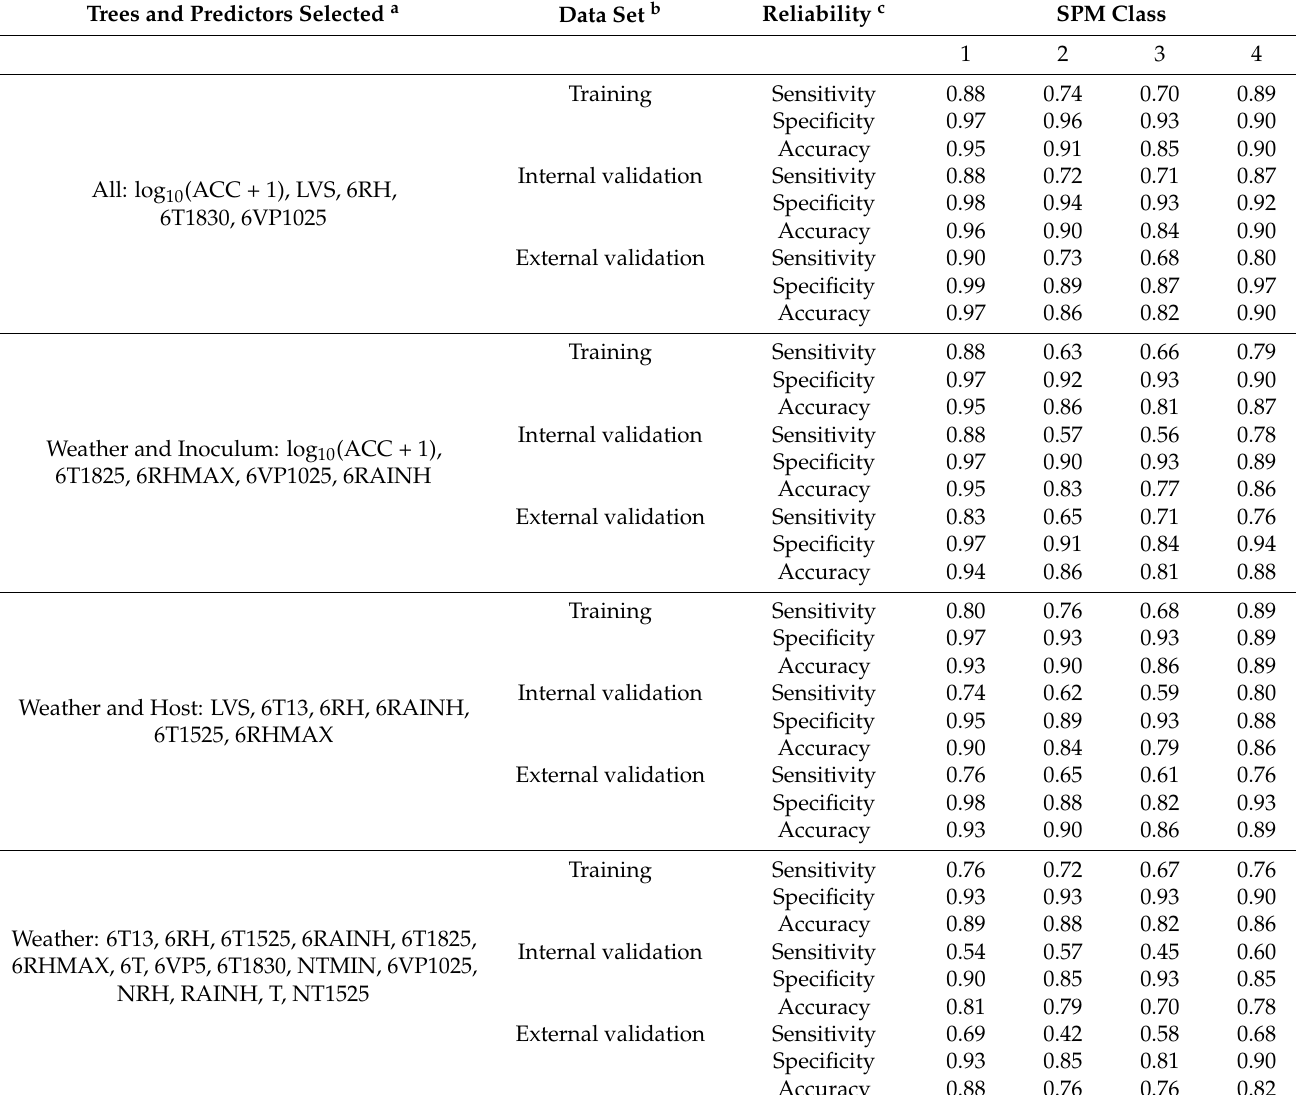
Table 2. Characteristics of the classification trees built with all predictors, weather and inoculum predictors, weather and host predictors, and only weather